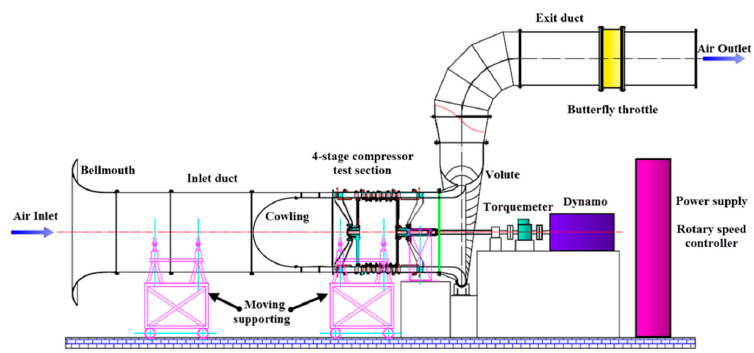
Figure 1. Schematic drawing of compressor test rig.